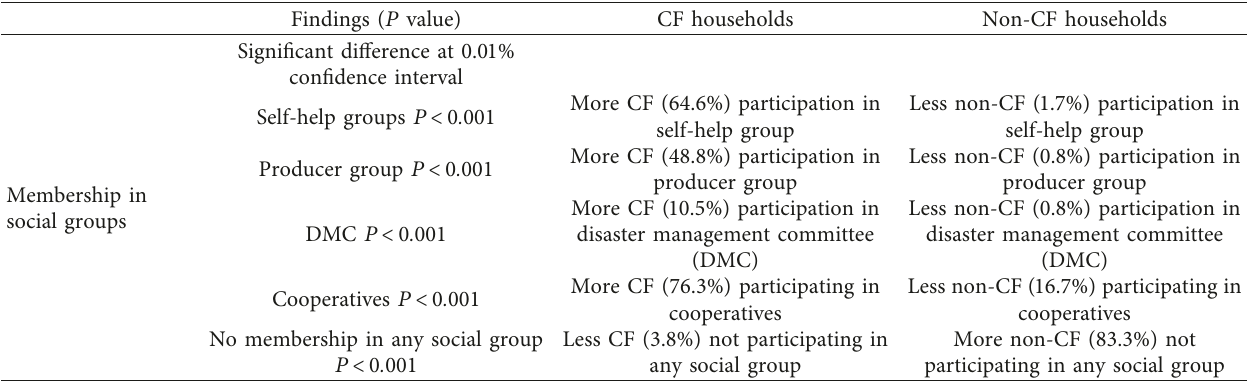
Table 4: Percentage of climate finance (CF) and nonclimate finance (non-CF) households who engaged in the adaptation measures.